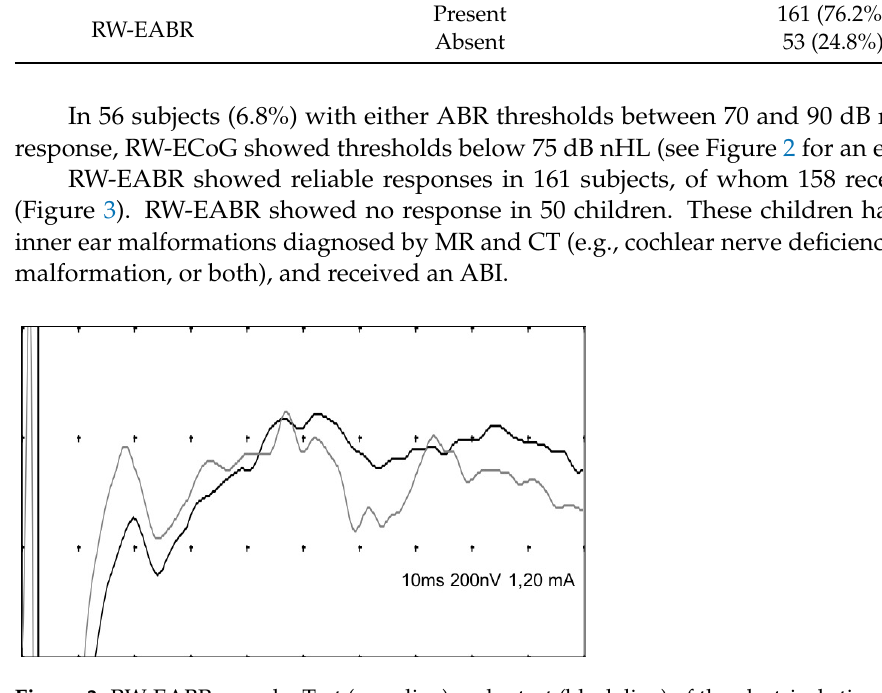
Figure 3. RW-EABR sample. Test (gray line) and retest (black line) of the electrical stimulus. No short-term or long-term complications (e.g., persistent tympanic membrane per- foration) due to either the testing protocol or general anesthesia were identified. Test